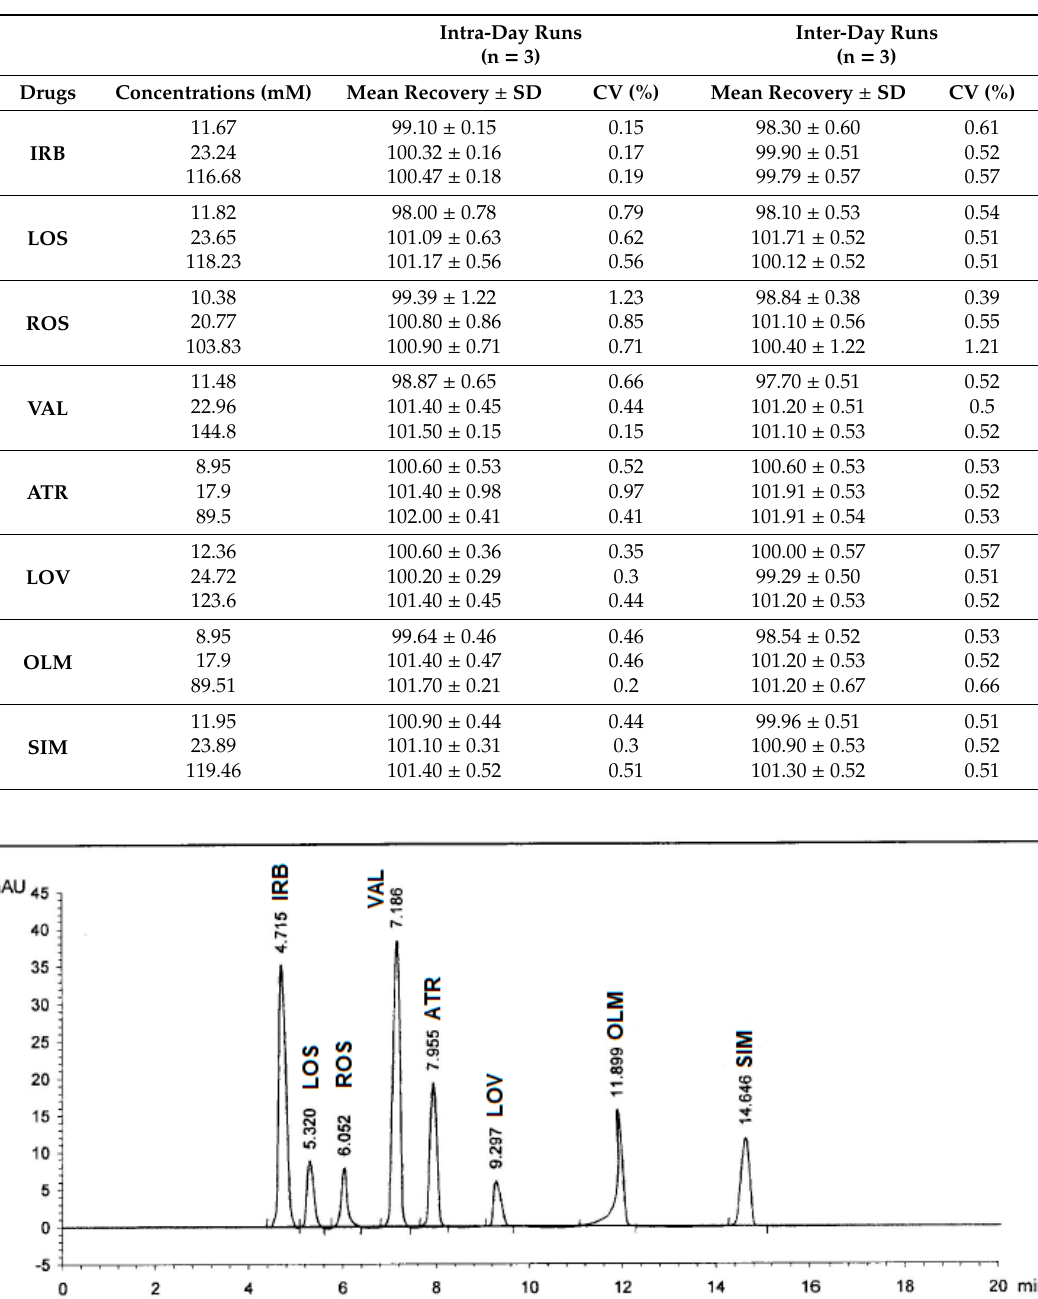
Table 4. Intra-andinter-dayprecisionresultsofsartansandstatinsinpuresamplesusingtheproposedmethod.